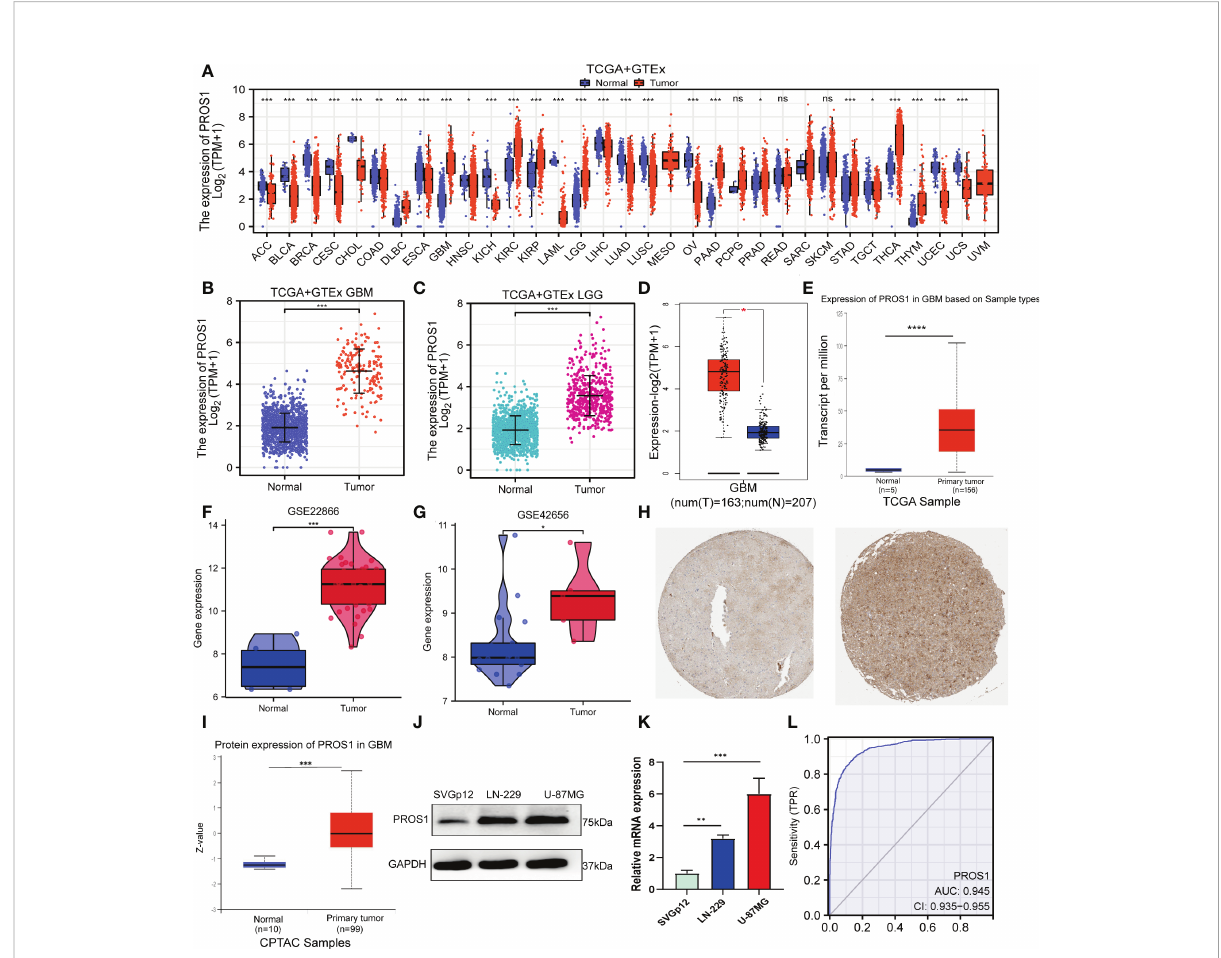
FIGURE 1 PROS1 expression levels between human cancer and normal tissues. (A) Pan-cancer analysis of PROS1 expression across all tumor samples and normal tissues from TCGA and GTEx database. (B, C) The PROS1 expression levels between tumor and normal tissues in GBM and LGG from TCGA and GTEx database. (D, E) The PROS1 expression levels between tumor and normal tissues in GBM from GEPIA and UALCAN. (F, G) The PROS1 expression levels between glioma and non-cancer tissues form GSE22866 and GSE42656. (H) Immunohistochemistry of PROS1 expression in the glioma tissue microarray cohort in the HPA database. (I) The protein expression of PROS1 between normal tissues and primary tumor tissues in the CPTAC dataset. (J, K) Western blotting and qRT-PCR assays the protein and mRNA expression of PROS1 in two tumor cell lines and one normal cell line (LN-229, U-87MG, and SVGp12). (L) ROC analysis of PROS1 expression shows promising discrimination power between glioma and non-tumor tissues. (ns, nonsigni fi cant; P > 0.05; *, P < 0.05; **, P < 0.01; ***, P < 0.001; ****, P <